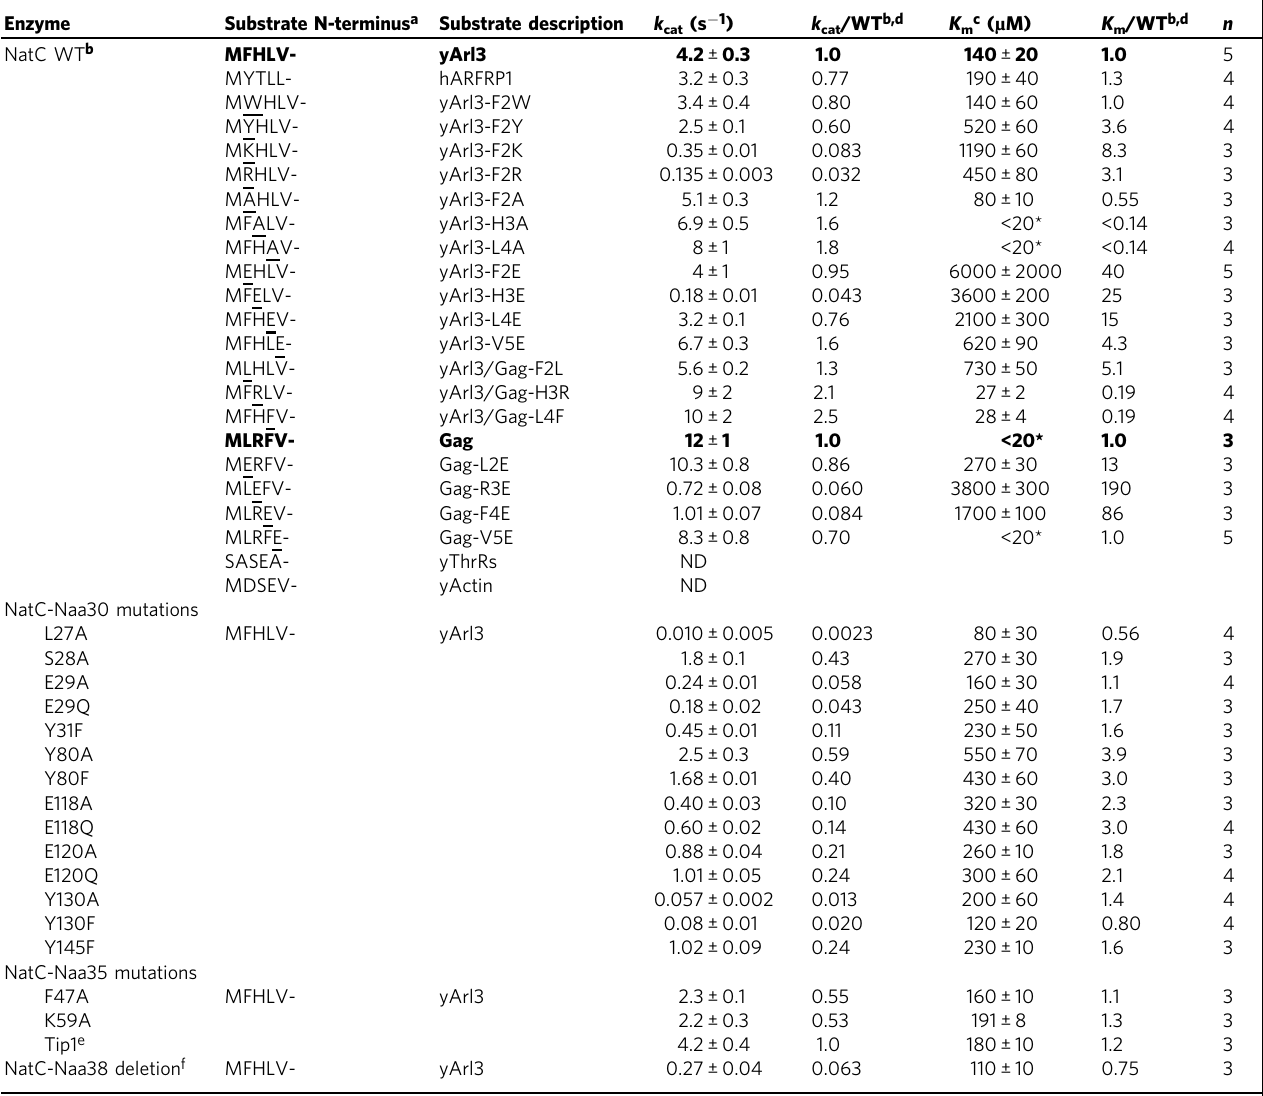
Table 2 Catalytic parameters for wild type and mutant NatC with various substrates. Enzyme Substrate N-terminus a Substrate